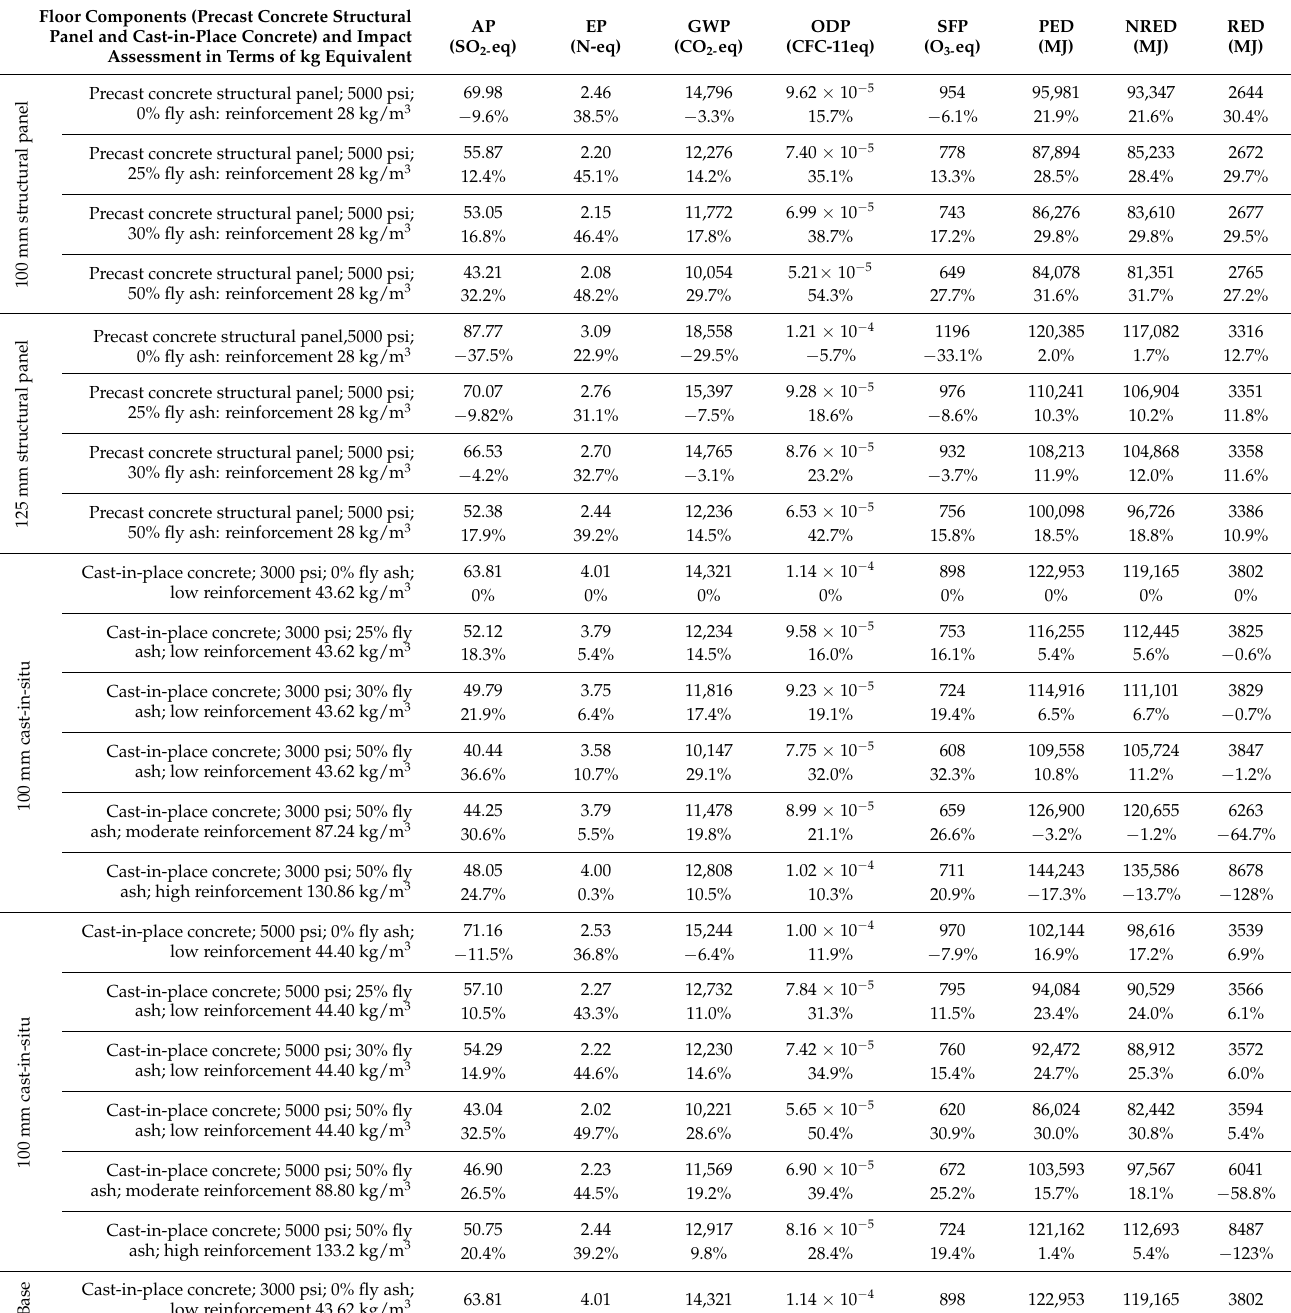
Table 7. Embodied energy of concrete panels for fly ash, compressive strength, and